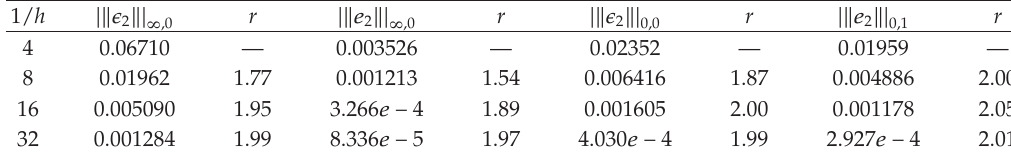
Table 4: Correction step approximation for λ (cid:9)